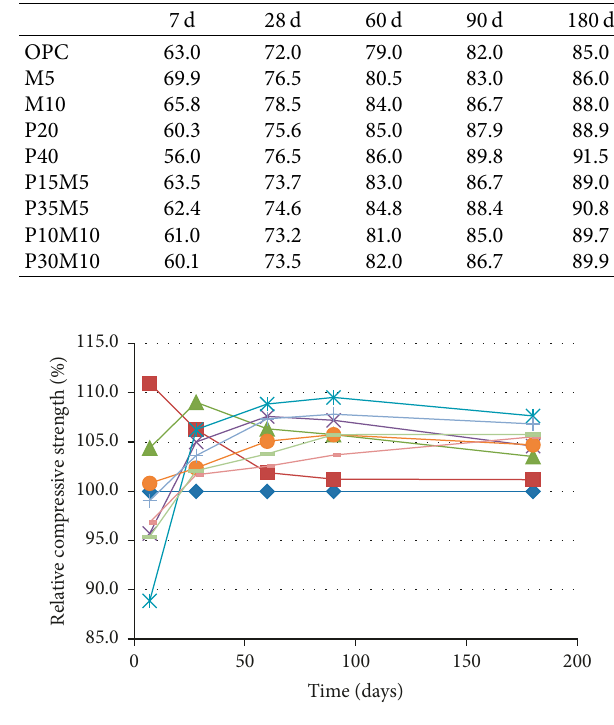
Figure 7: Concrete slump flow table Table 4: Compressive strength of concrete.